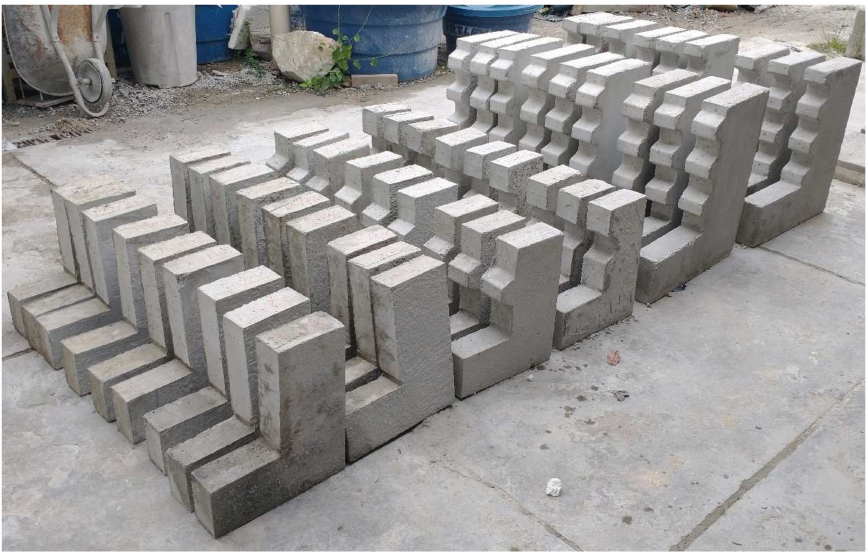
Figure 8. Dry joint specimens with recycled coarse aggregates